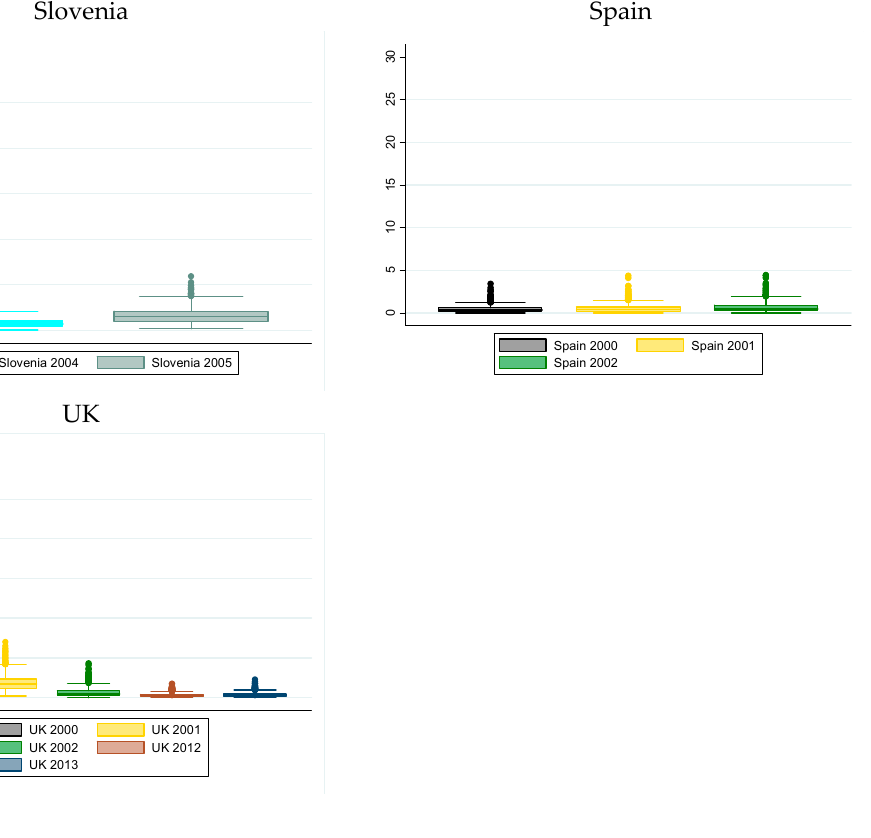
Figure 1. Box ‐ plot of probability of finding non ‐ compliant food products per country and year. Figure 1. Box-plot of probability of finding non-compliant food products per country and